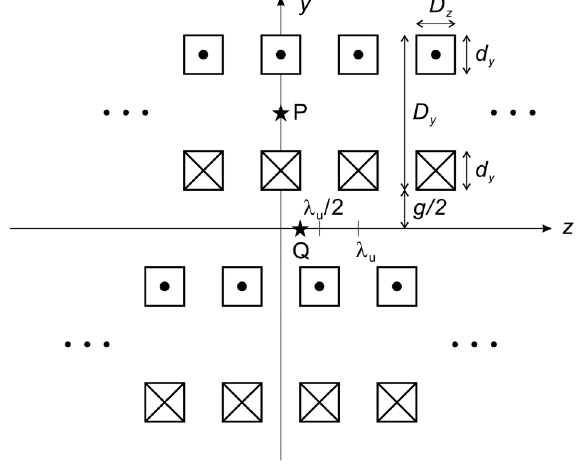
FIG. 2. Geometry used for analytical